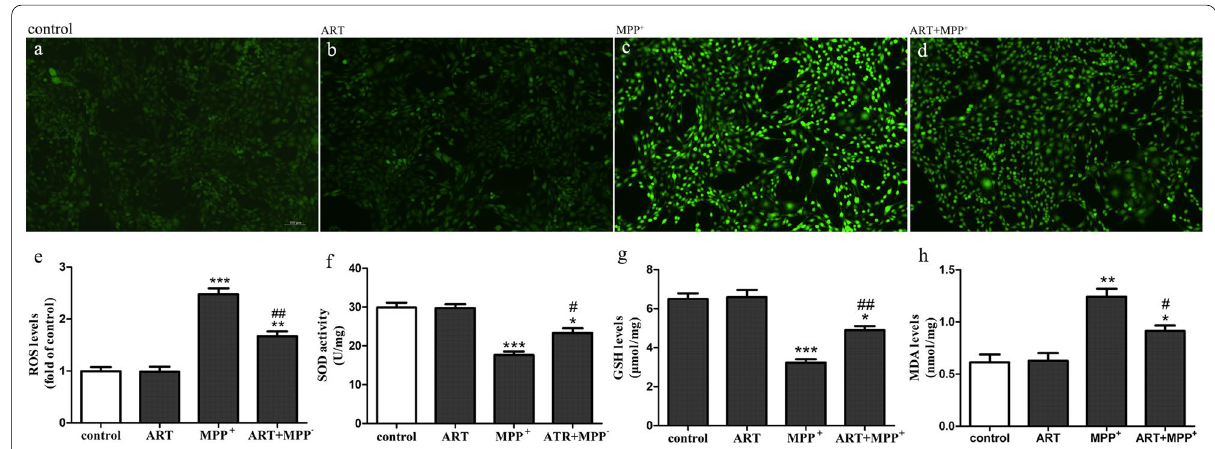
Fig. 2 ART reduced the oxidative stress injury induced by MPP + . The level of intracellular ROS production was measured using a DCFH-DA fluorescent probe ( a – d ), and the fluorescence intensity was analyzed by ImageJ ( e ). The fluorescence intensity of the control group was set to 1, and the fluorescence intensity of the other groups was compared with that of the control group. ART increased the SOD activity ( f ) and GSH production ( g ) and decreased the MDA production ( h ) compared with MPP + . Scale bar (n 5), * p < 0.05, ** p < 0.01, *** p < 0.001 vs. control; # p < 0.05, ## p < 0.01 vs. MPP =